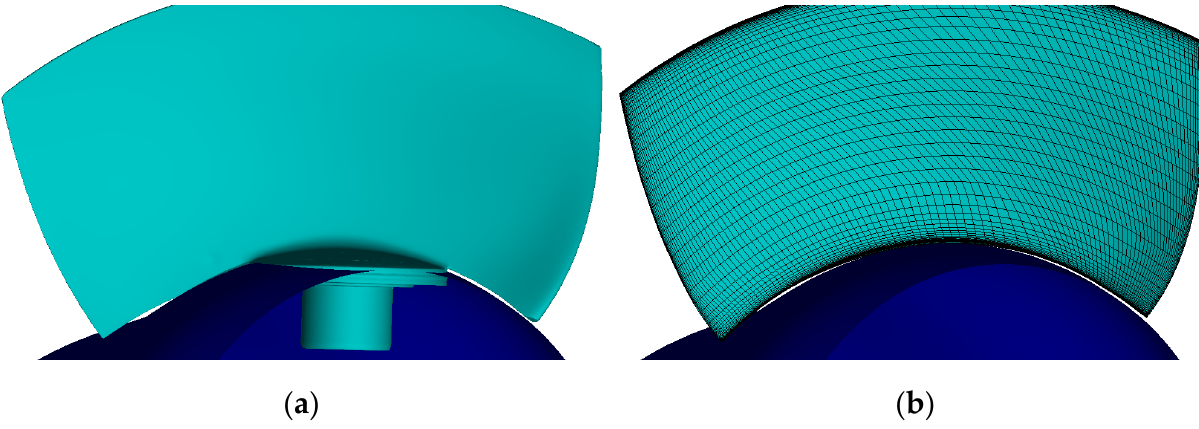
Figure 2. ( a ) Real variable hub clearance of the scanned model blade. ( b ) Constant hub clearance modeled for the prototype blade.